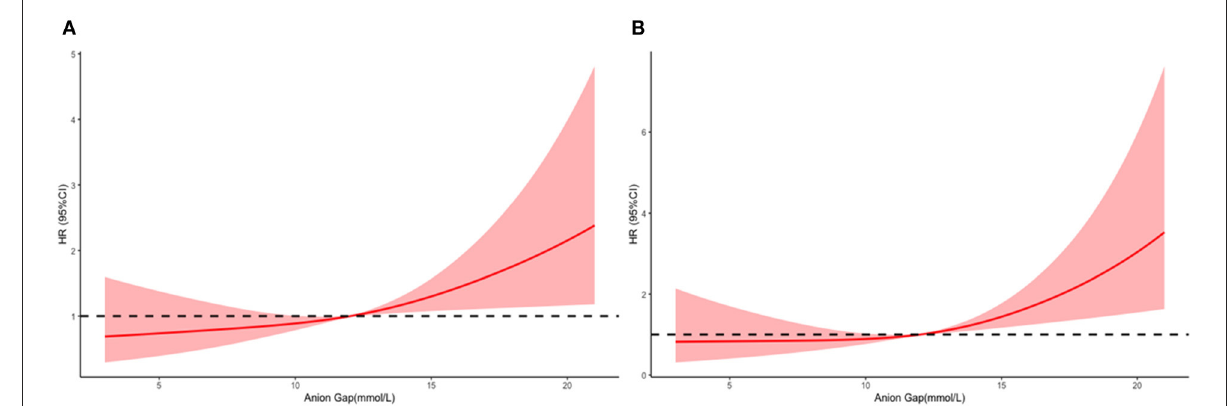
FIGURE2 Multivariable adjusted hazard ratios (HRs) for all-cause mortality according to levels of anion gap (AG) on a continuous scale (mmol/L). Solid deep red lines are multivariable-adjusted HRs. Light red areas are the 95% confidence intervals derived from restricted cubic spline regressions with 3 knots. Dashed black lines are reference lines for no association at a hazard ratio of 1.0. In general, in-hospital (A) and ICU (B) , mortality are increased as AG concentration increased. In-hospital mortality analysis is adjusted for age, systolic blood pressure, diastolic blood pressure, respiratory rate, temperature, SPO2, mild liver disease, serve liver disease, renal disease, malignant cancer, Charlson Comorbidity Index, SOFA score, bicarbonate, creatinine, glucose, hematocrit, hemoglobin, platelets, potassium, BUN, WBC count, and calcium. ICU mortality analysis is adjusted for age, heart rate, systolic blood pressure, diastolic blood pressure, respiratory rate, temperature, SPO2, mild liver disease, serve liver disease, myocardial infarction, paraplegia, renal disease, malignant cancer, Charlson Comorbidity Index, SOFA score, bicarbonate, creatinine, glucose, hemoglobin, platelets, potassium, BUN, WBC count, and calcium.